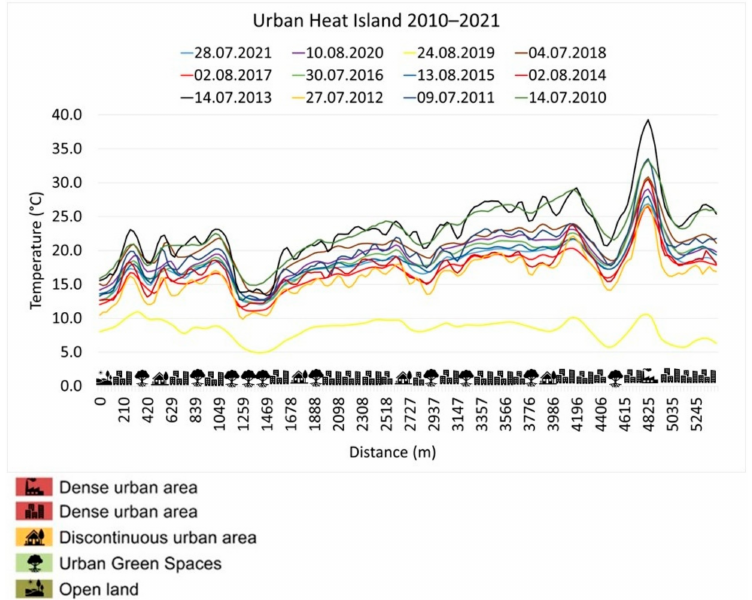
Figure 7. The course of LST on the profile line for individual years in